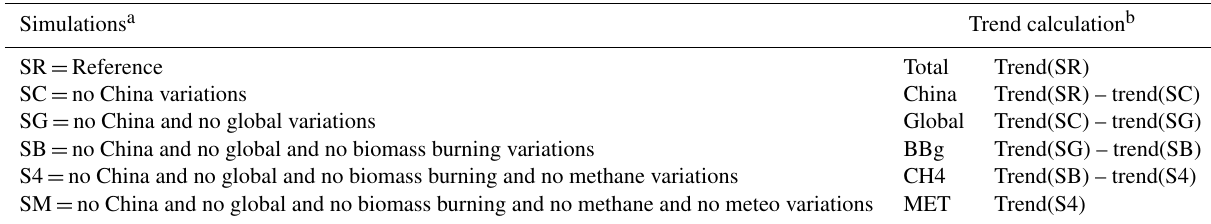
Table 4. Description of the different simulations done with the INCA model and the trends calculation. Note that, for all the simulations, the biogenic emissions are constant over the